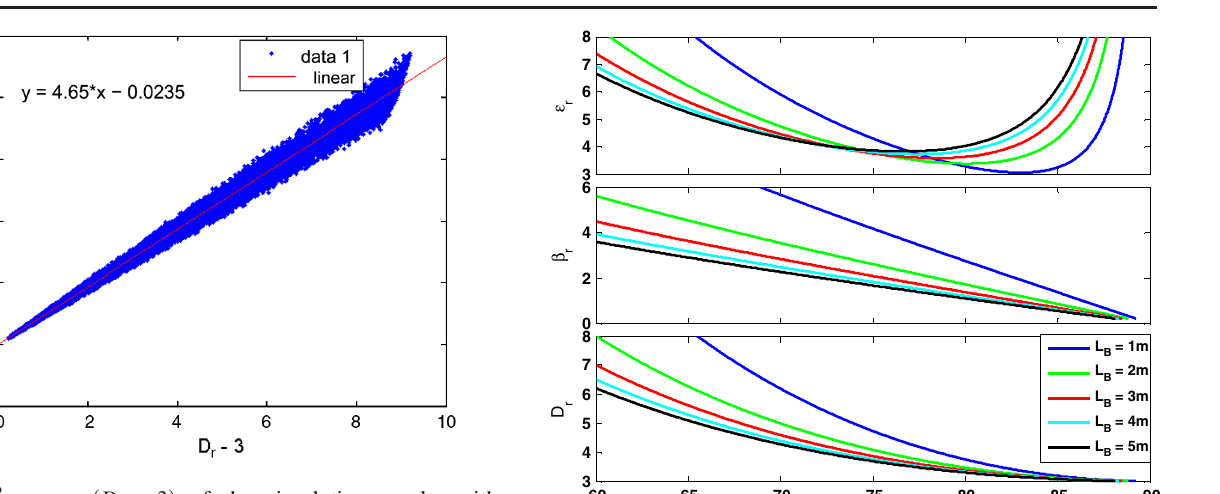
FIG. 5. (cid:5) 2 r versus ð D r (cid:1) 3 Þ of the simulation results with < 10 and L ¼ 3 : 5 m . " r B